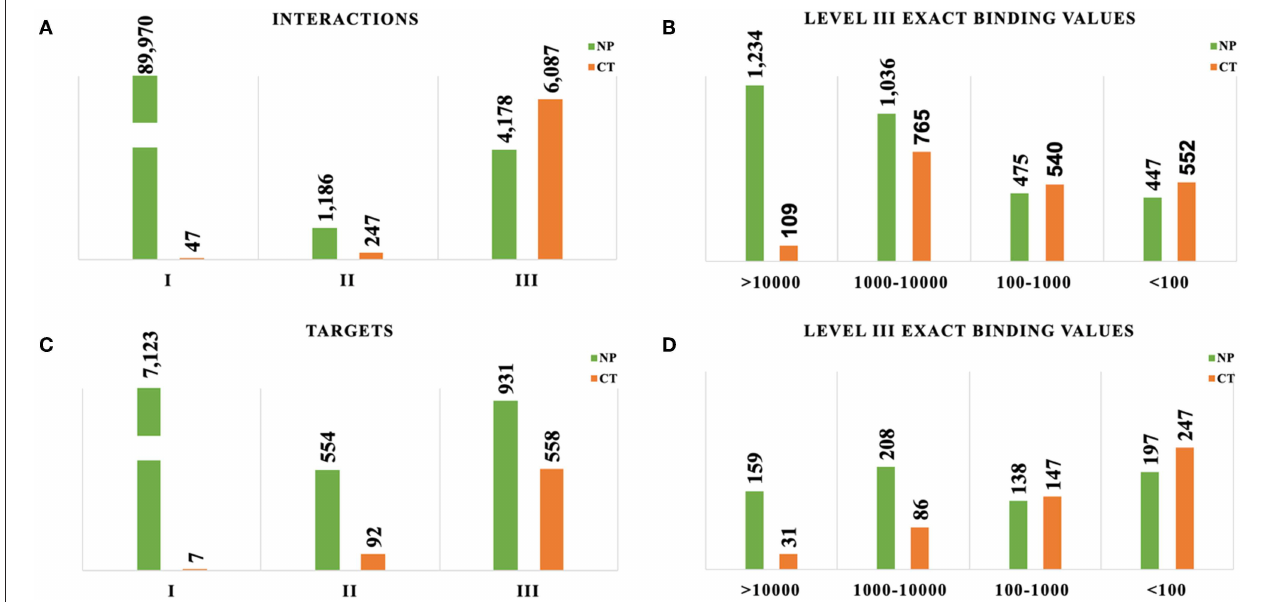
FIGURE 2 | Assessment of evidence levels for target and compound-target interactions. CT, Cancer Targetome; NP, Natural Product Target Network. (A) Comparison of interaction distribution by evidence level between NPs and CT drugs. (B) Comparison of interaction distribution at high affinity only (evidence level III exact values in nM). (C) Comparison of maximum target evidence level distribution between NPs and CT drugs. (D) Comparison of maximum target evidence level distribution at high affinity only (evidence level III exact values in